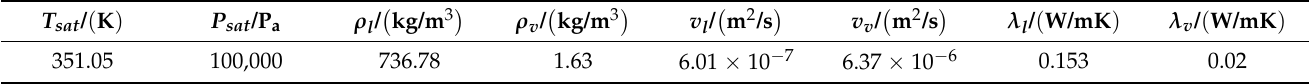
Figure 1. ( a ) Computational domain, boundary conditions, and mesh details. ( b ) Developed thermal boundary layer at the end of the first stage of simulations (single-phase). ( c ) Position of the 30 patched bubble seeds that has been used for all the numerical simulations at the beginning of the second stage (referred as initial time t = 0 ms). Table 2. Ethanol properties at saturation temperature.